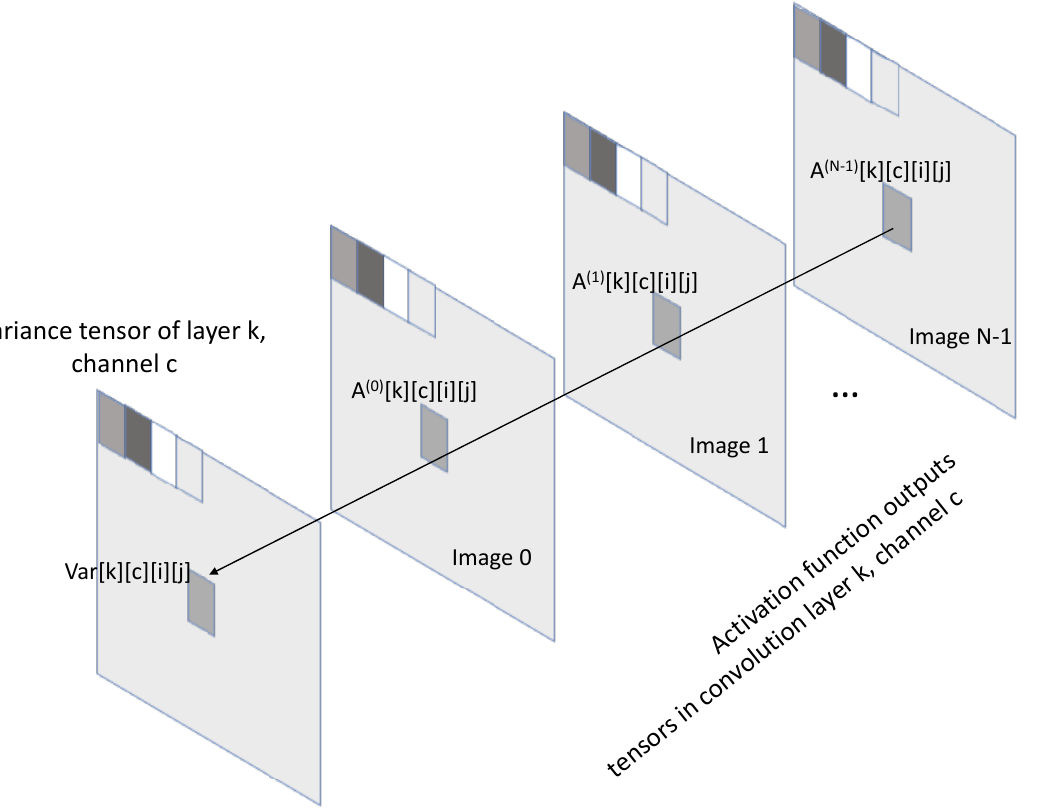
Figure 3. Value locality measured by the variance tensor V.